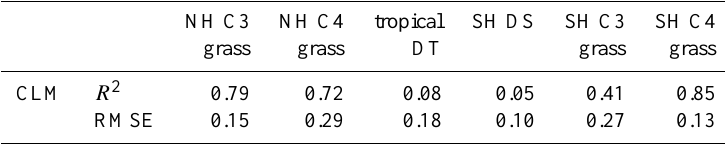
Table 2. R 2 and RMSE of AVHRR LAI3g v. CLM monthly data for all 29 years.